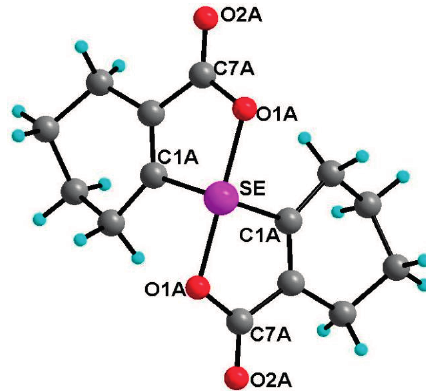
Figure 5. Molecular structure of compound 20 . Selected bond lengths (Å) and bond angles (°);